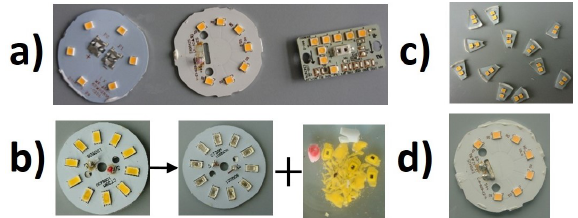
Figure 1. ( a ) LED modules used for the characterization of the construction of LED packages by MLA: ( b ) detachment of LED chips and encapsulation for chemical analysis; ( c ) LED module pieces used in tests; ( d ) LED module used in comparative